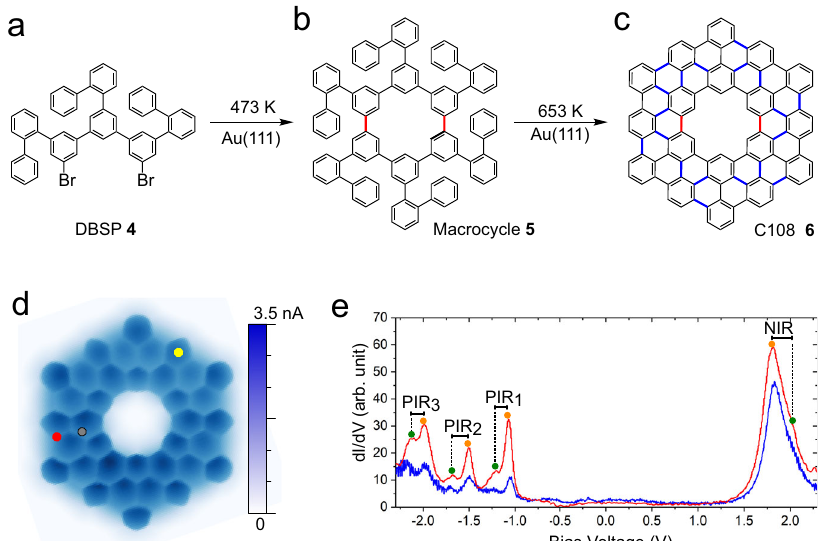
Fig. 1 Synthesis, structural and electronic properties of C108. The precursor 5'''-([1,1'-biphenyl] − 2-yl) − 5'',5''''-dibromo-1,1':2',1'':3'',1''':3''',1'''':3'''',1''''':2''''',1''''''- septiphenyl (DBSP) ( a ) is vapor-deposited onto the surface. Subsequent annealing induces an Ullmann coupling, resulting in the nonplanar macrocycle ( b ). Upon further annealing,theC108 macrocycleis formed by cyclodehydrogenation ( c ).TheC – Cbonds formedvia Ullmann and dehydrogenativecoupling areshownin red and blue, respectively. d Constant-height STM image of the C108 nanoring ( V = 20mV, size 2.4×2.4nm 2 ). The red and gray dots mark the locations at which the spectra in Fig. 2b were recorded. e d I/ d V spectra taken with a metallic (blue) and a CO tip (red), measured over the yellow dot marked in d . Main features (orange dots) and their replicas (green dots) are labeled with PIR 1 , PIR 2 , PIR 3 and NIR ( V = 200mV, I = 80 pA, V mod =